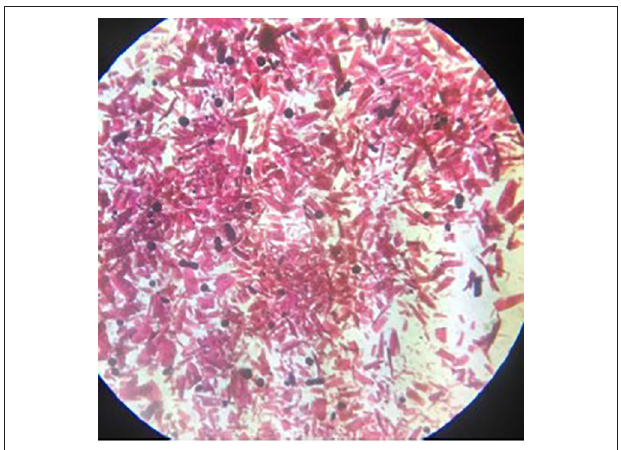
FIGURE 2 | Stereoscopic microscopy of